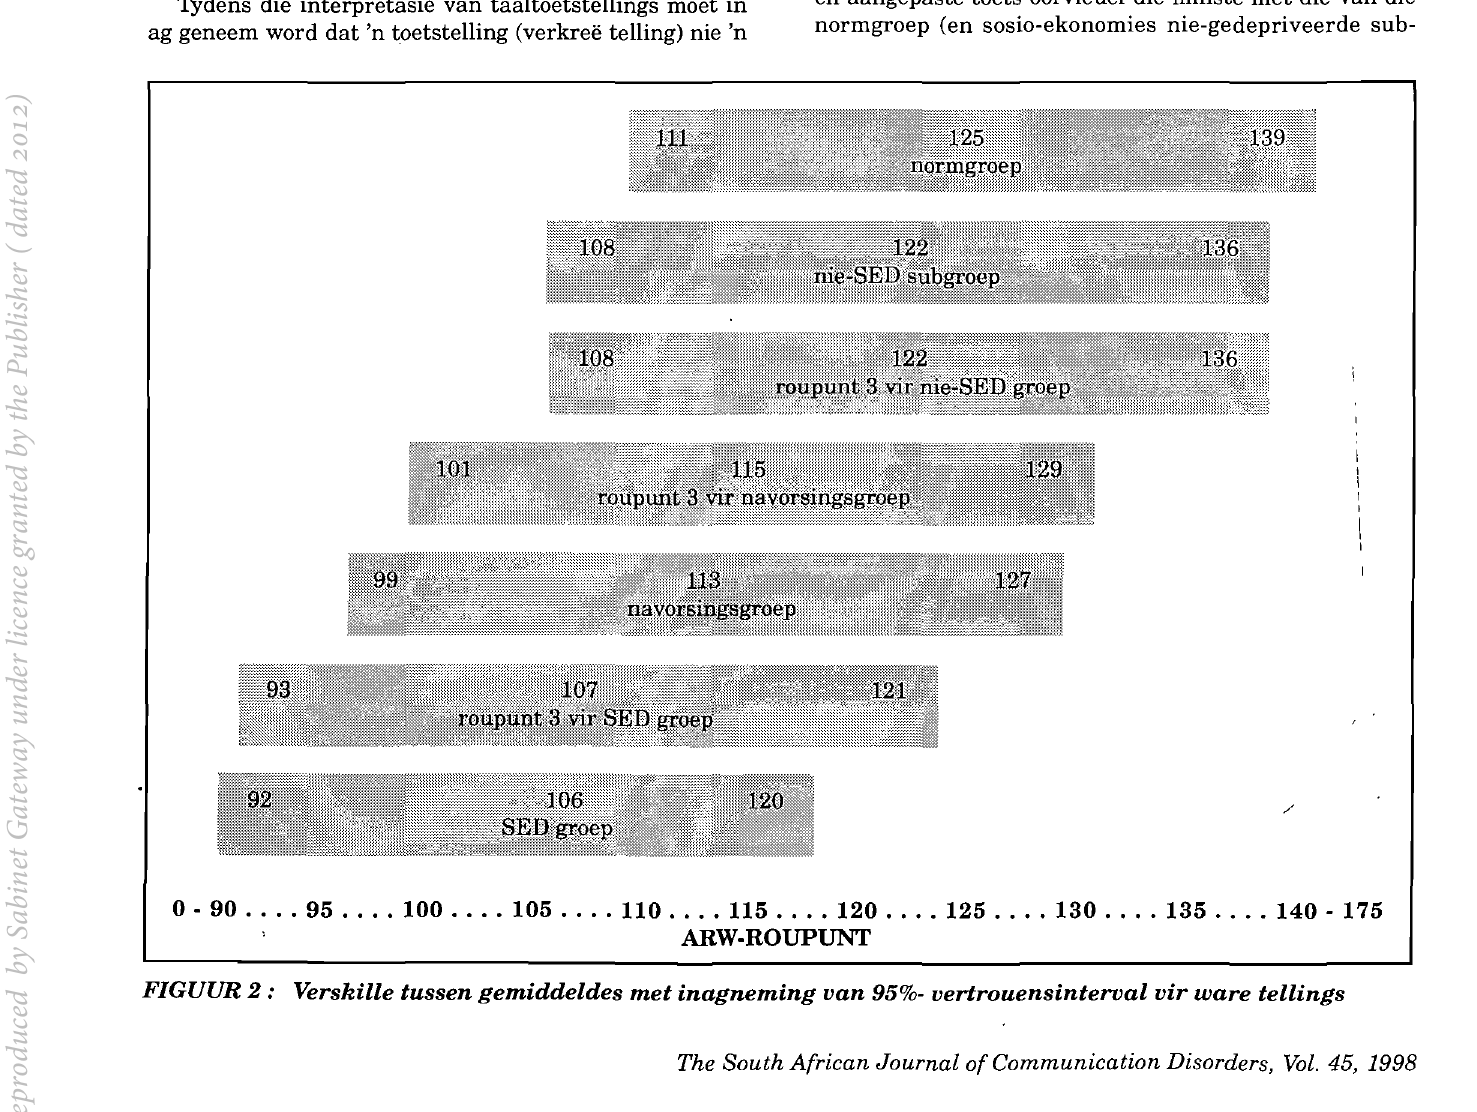
FIGUUR 2: Verskille tussen gemiddeldes met inagneming van 95%- vertrouensinterval vir ware tellings The South African Journal of Communication Disorders, Vol. 45,